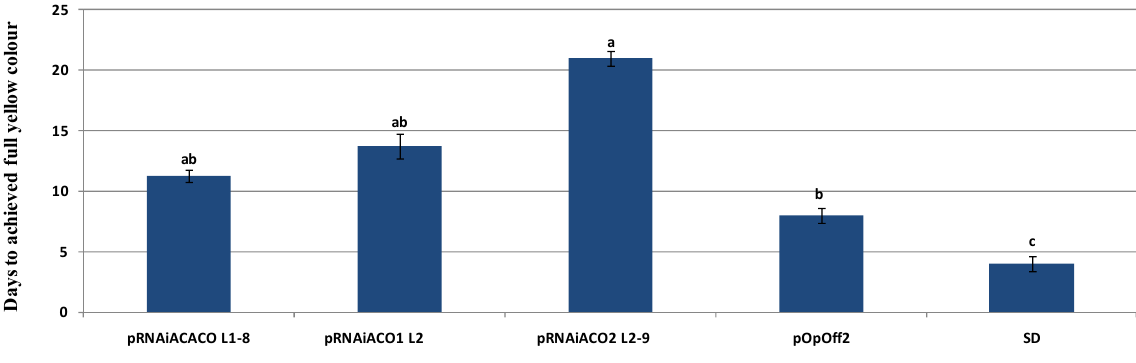
Figure 3. Shelf life analysis of RNAi Transgenic Papaya Plants. Lines pRNAiCACOL1-8, pRNAiACO1 L2 and pRNAiACO2 L2-9 are the transgenic lines. pOpOff2 is the